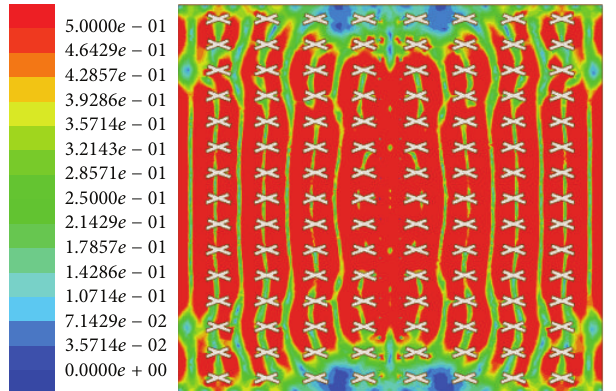
Figure 8: Electric current distribution at the surface of the slot array at 5.85